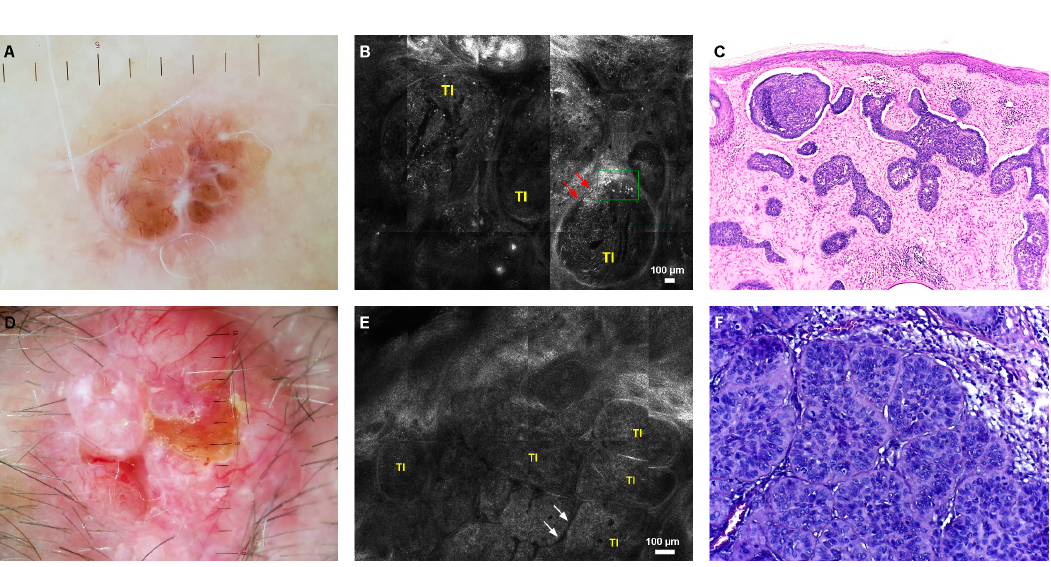
Figure 3. Nodular basal cell carcinoma. ( A ) Dermoscopy image of a pigmented nodular basal cell carcinoma (nBCC) with blue-gray ovoid nests, brown globules, and arborizing vessels. ( B ) RCM revealed large, well defined tumor islands (TI), peritumoral clefting (red arrows), and clumped melanophages (green rectangle). ( C ) Histopathology showed large basaloid islands with palisading and stromal retraction in the dermis (H&E stain, magnification 4×). ( D ) Dermoscopy of hypopigmented nBCC with ulceration and arborizing vessels. ( E ) RCM showed large tumor islands (TI) with peripheral palisading and clefting (white arrows). ( F ) Histopathologic correlates of the structures seen through RCM (H&E stain, magnification 40×).